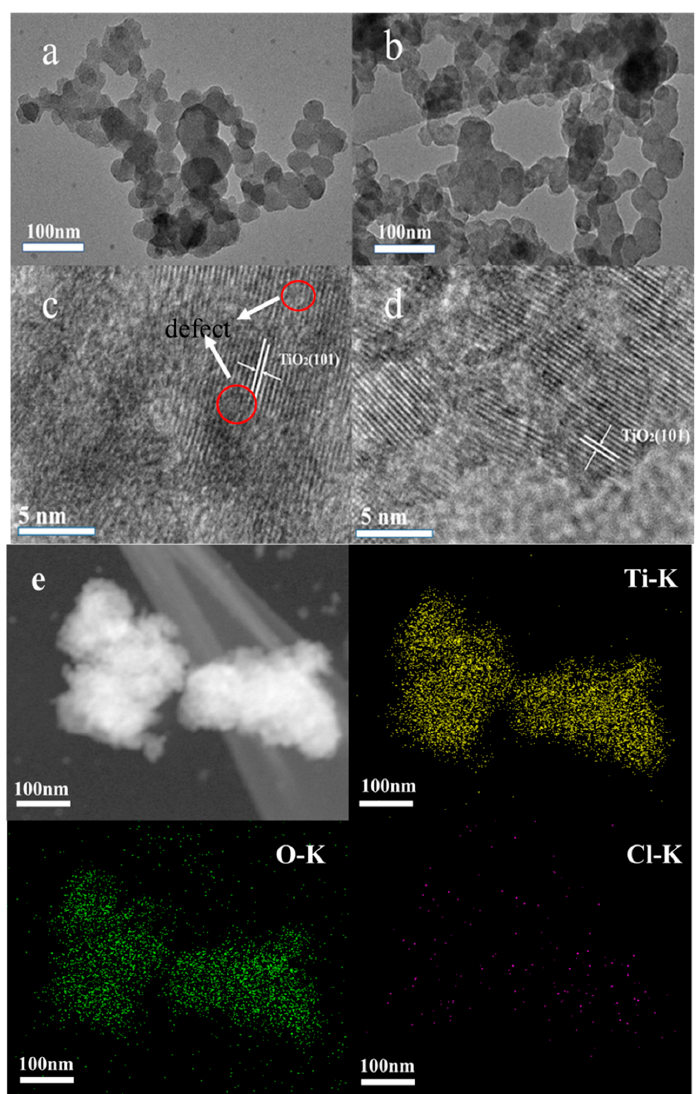
Figure 2. Low-resolution and high-resolution transmission-electron micrographs of ( a , c ) Cl-TiO 2 and ( b , d ) P25. ( e ) Energy-dispersive X-ray spectrum EDX maps of Ti, O, and Cl in Cl-TiO 2 .